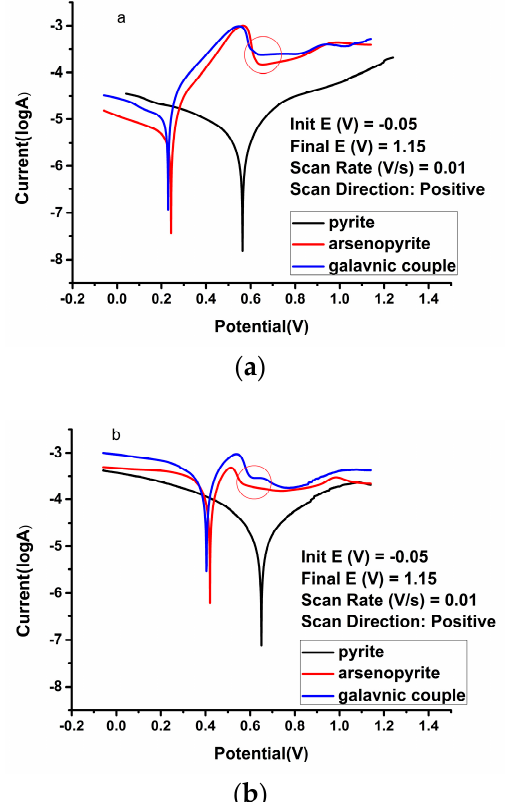
Figure 3. Linear sweep voltammetry curves of the three investigated electrodes in sulfuric acid ( a ), ferric ion ( b ), and HQ0211 strain solutions ( c ) (Init E: Initial potential of linear sweep voltammetry test, Final E: Final potential of linear sweep voltammetry test).